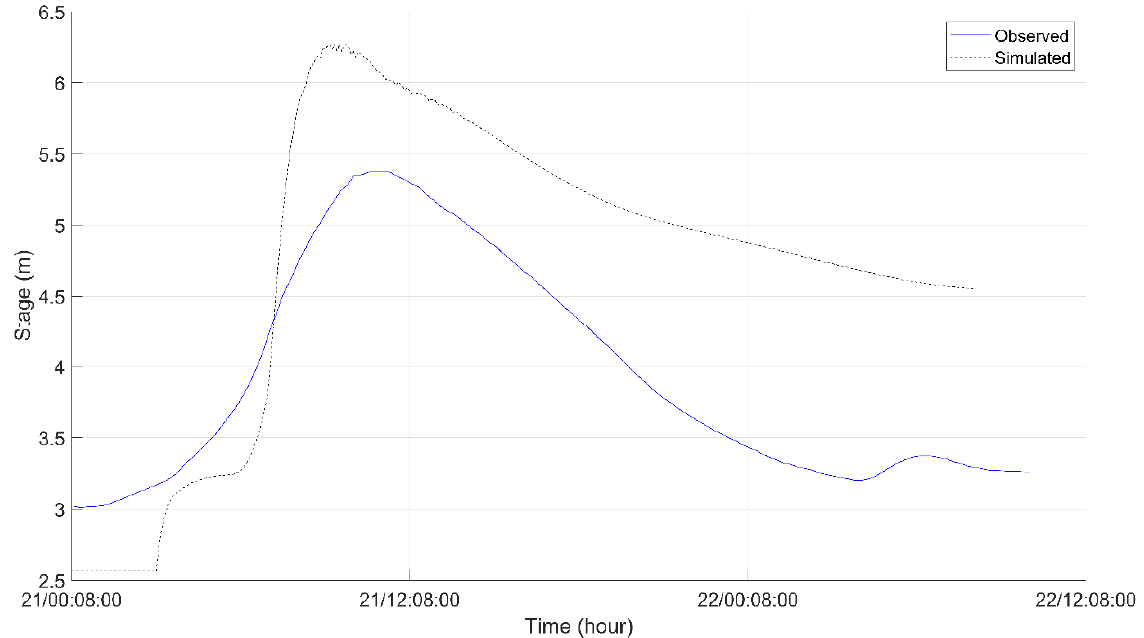
Figure 5. Comparison of the observed and HEC-RAS simulated stage that occurred on the 21 August 2020 at gauge G3 (“Pont Ngongue”) in Makèpè Missokè.